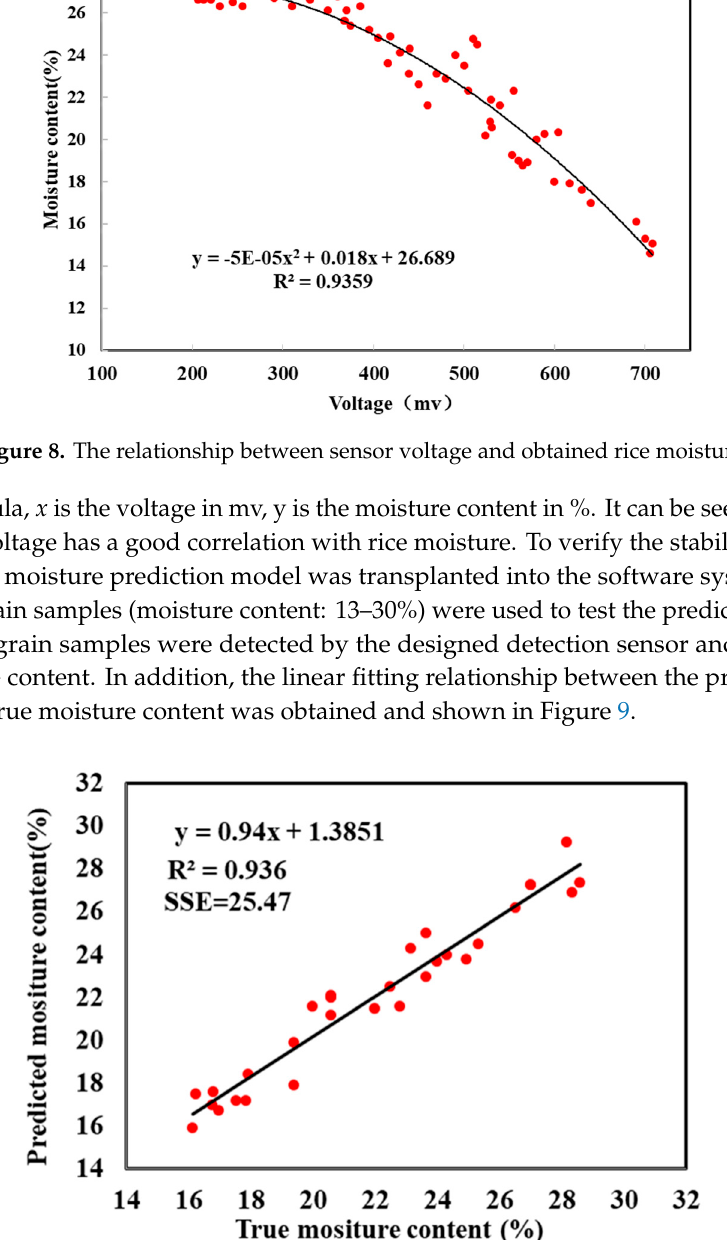
Figure 7. The detection process for test the sensor performance.